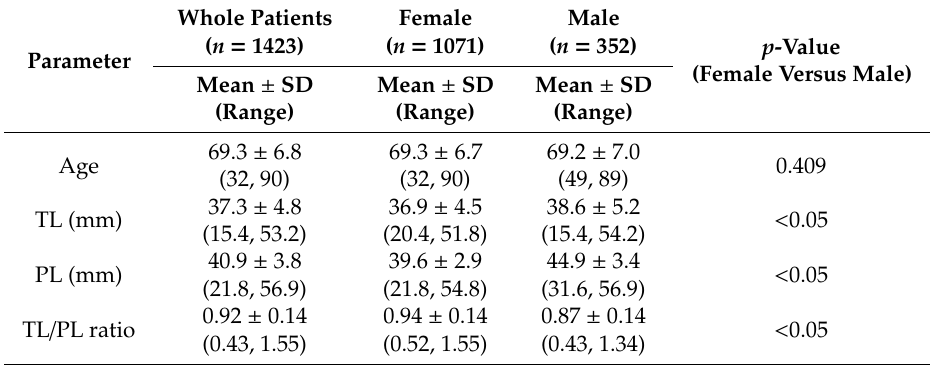
Table 1. Comparison of the age, TL, PL, TL / PL ratio among the Korean population.